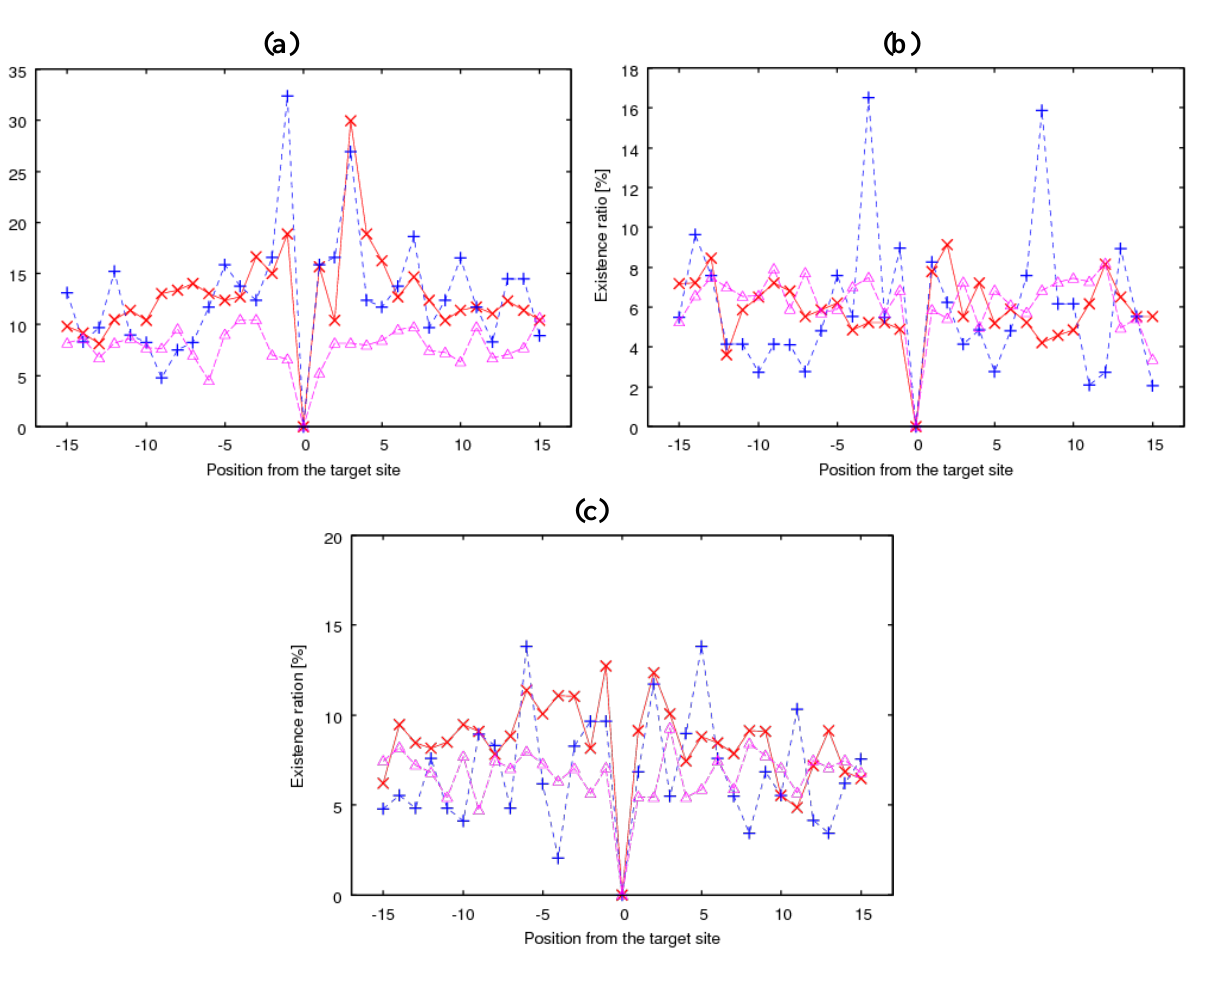
Figure 3. ( a ) Existence ratios of Pro at each position for clustered positive, isolated positive, and negative Ser or Thr sites (indicated by red crosses, blue crosses, and pink triangles, respectively). Existence ratios of Val ( b ) and Ala (c) shown in a similar